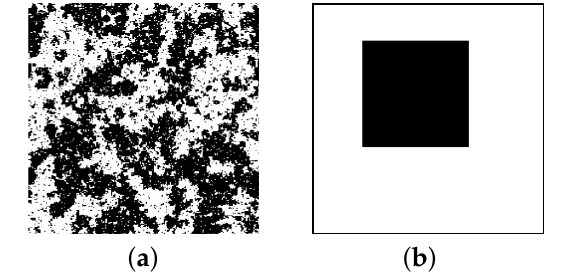
Figure 2. One bit pixel images obtained from ( a ) magnetic Ising model fluctuations, and ( b ) a black square on white background